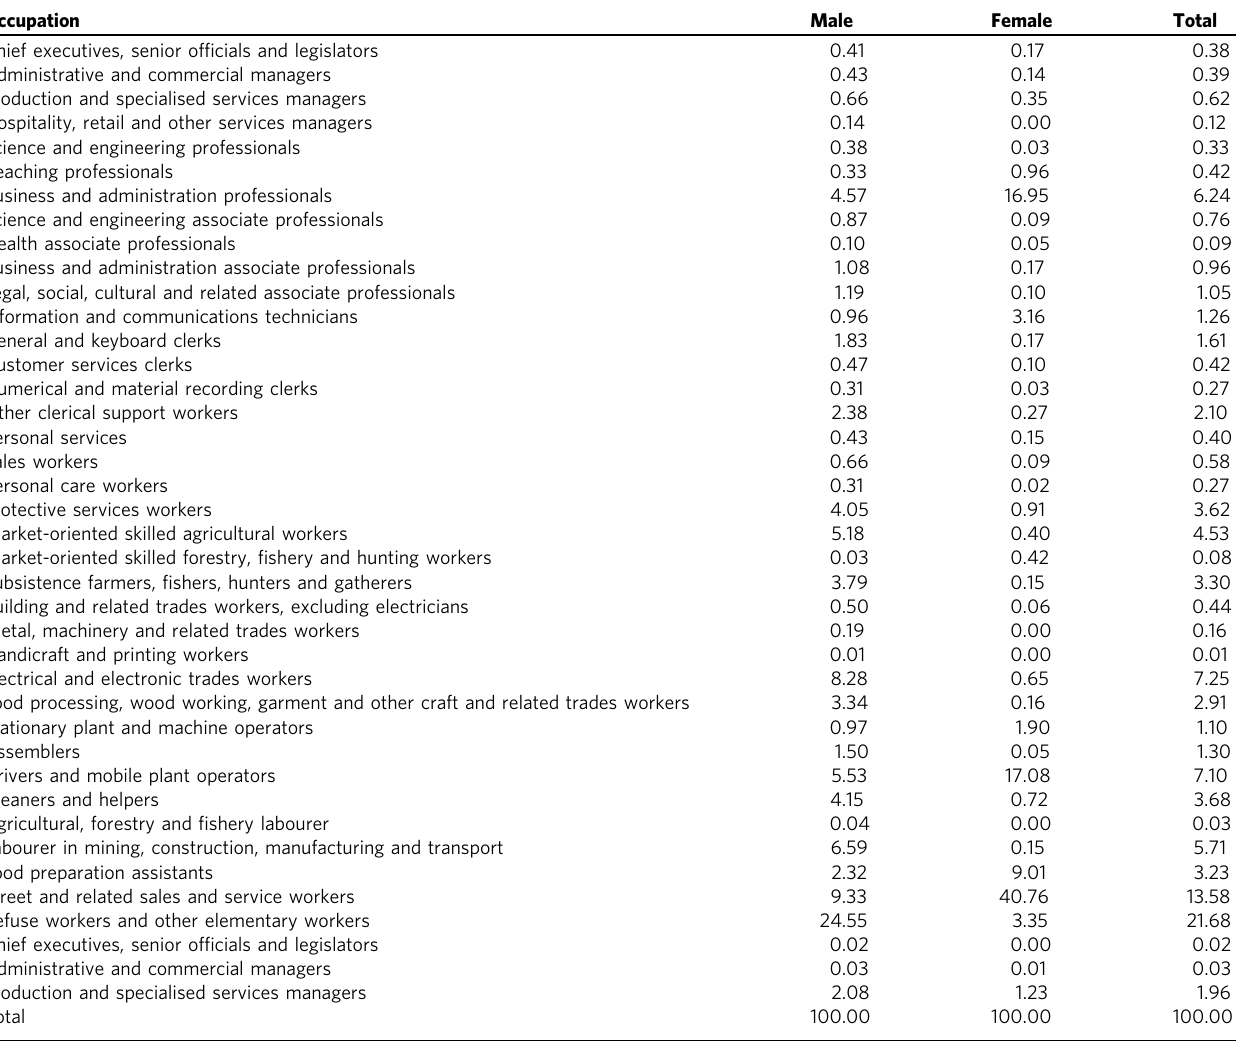
Table 2 Composition of labour force across occupations. Occupation